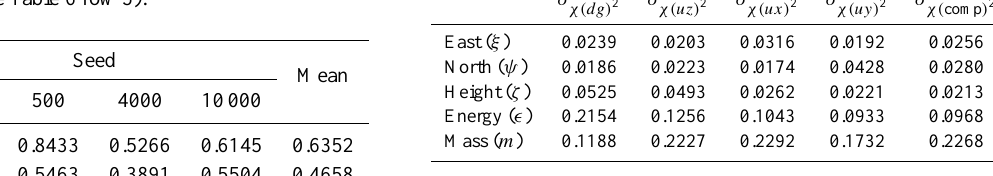
Table 4. Nonnormalized E-FAST TSIs for the five defined output parameters with respect to the mass component m with 4 different seeds (1, 500, 4000, 10000) and the mean TSIs of 30 executions (the standard deviation see Table 6 row 5).